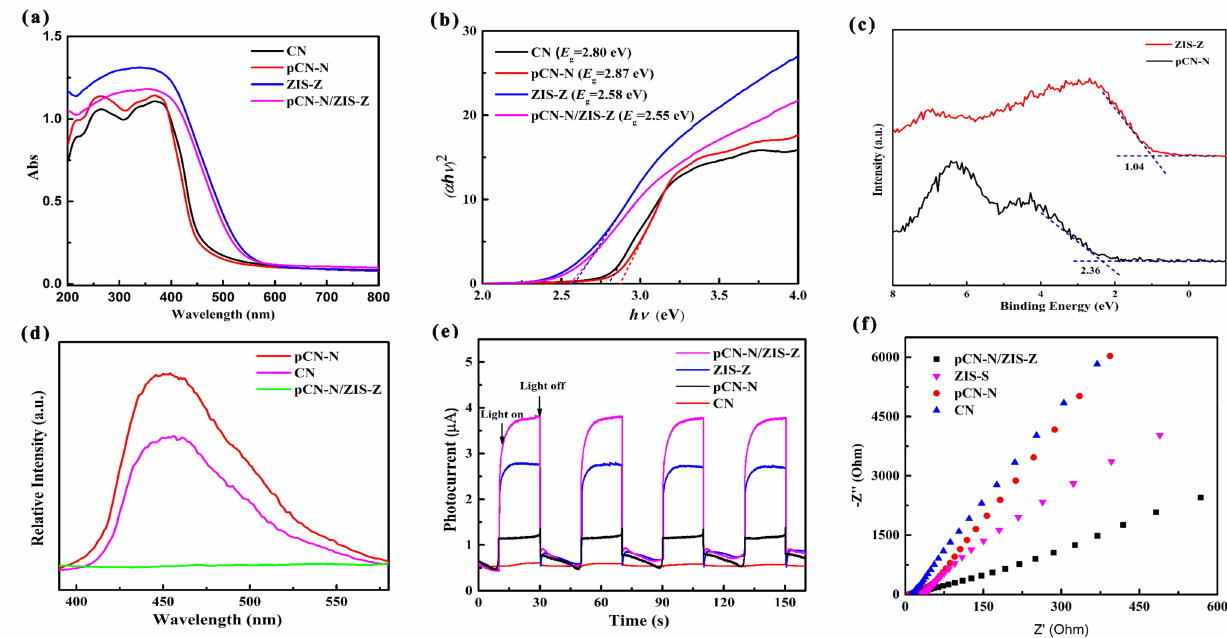
Figure 10. The UV–vis diffuse reflectance spectra ( a ), Plot of ( α h ν ) 2 vs. h ν for the bandgap energy ( b ) of different photo- catalysts. XPS valence band spectra of ZIS-Z and pCN-N ( c ). The photoluminescence spectra ( d ), transient photocurrent responses ( e ), and electrochemical impedance spectroscopy ( f ) of different